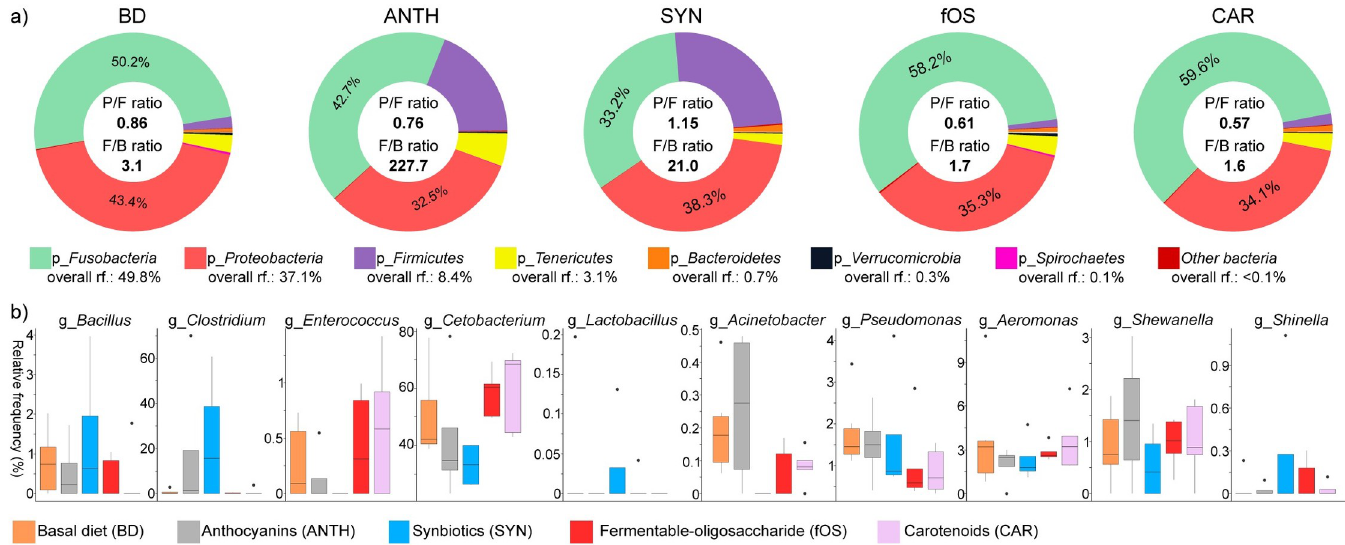
Fig 5. Diets enriched in phytonutrients affect important beneficial and potentially detrimental members of the Cyprinus carpio GIT. a) Donut plots represent diet- specific distortions in the main phyla. The Firmicutes -to- Bacteroidetes ratio (F/B ratio) and Proteobacteria -to- Firmicutes ratio (P/F ratio) are shown. b) Boxplots allow comparisons of the relative proportions of important general; specifically, relevant genera in the different groups are represented as boxplots. BD represents fish that received a basal diet, which served as a negative control with no dietary supplement or the following dietary treatments as supplemented feed: BD+1% anthocyanins (ANTH) provided by Hungarian sour cherry extract, BD+1% synbiotics (SYN) provided by fermented corn, BD+1% fermentable oligosaccharides (fOS) provided by Hungarian sweet red pepper seed extract, and BD+1% carotenoids (CAR) provided by Hungarian sweet red pepper pulp extract.